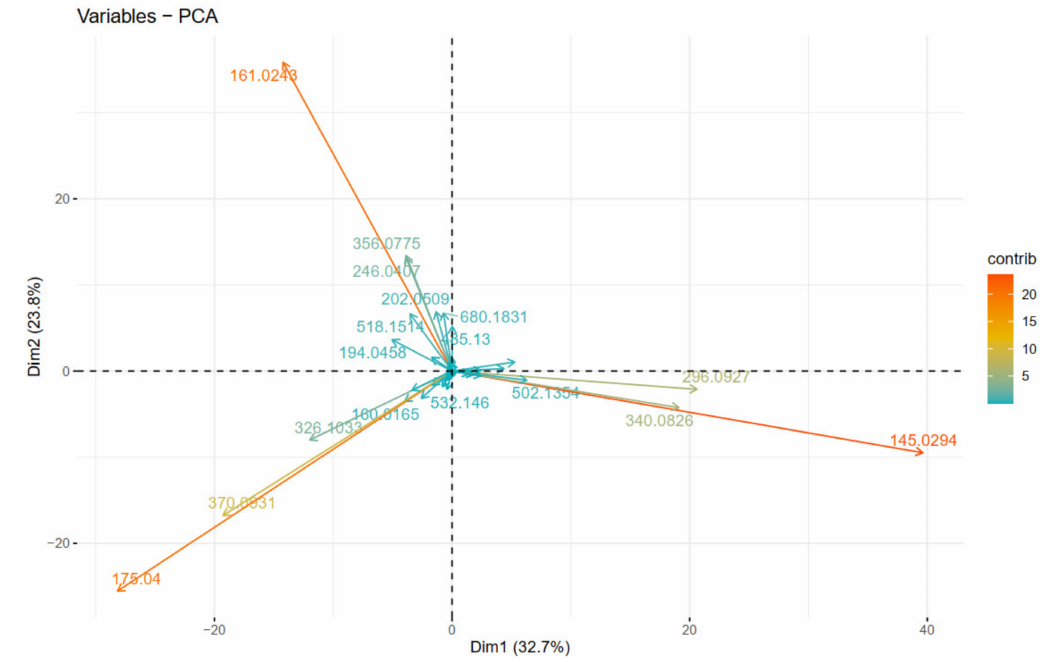
Figure 8. PCA plot of variables (fragment